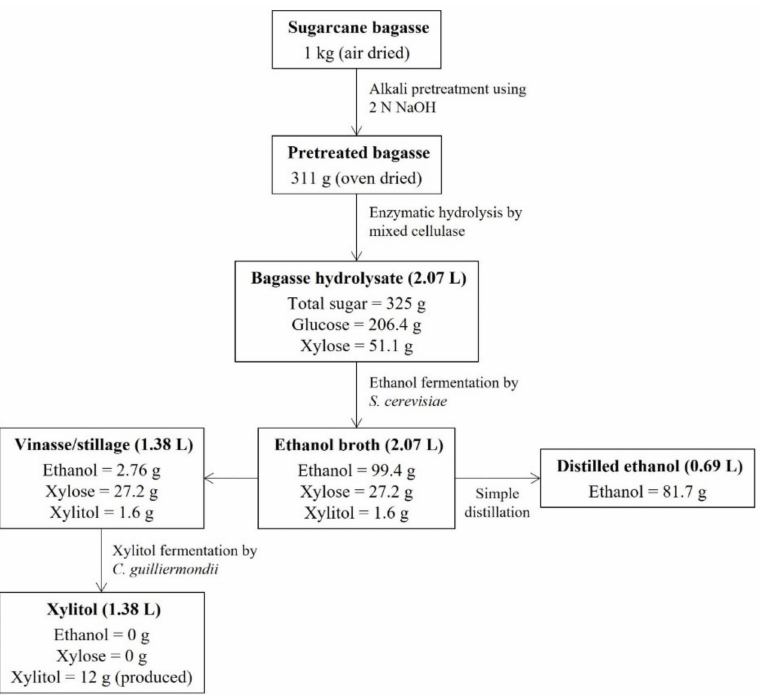
Figure 5. Diagram of the proposed ethanol and xylitol production process, illustrating important substrates and products at each stage of the